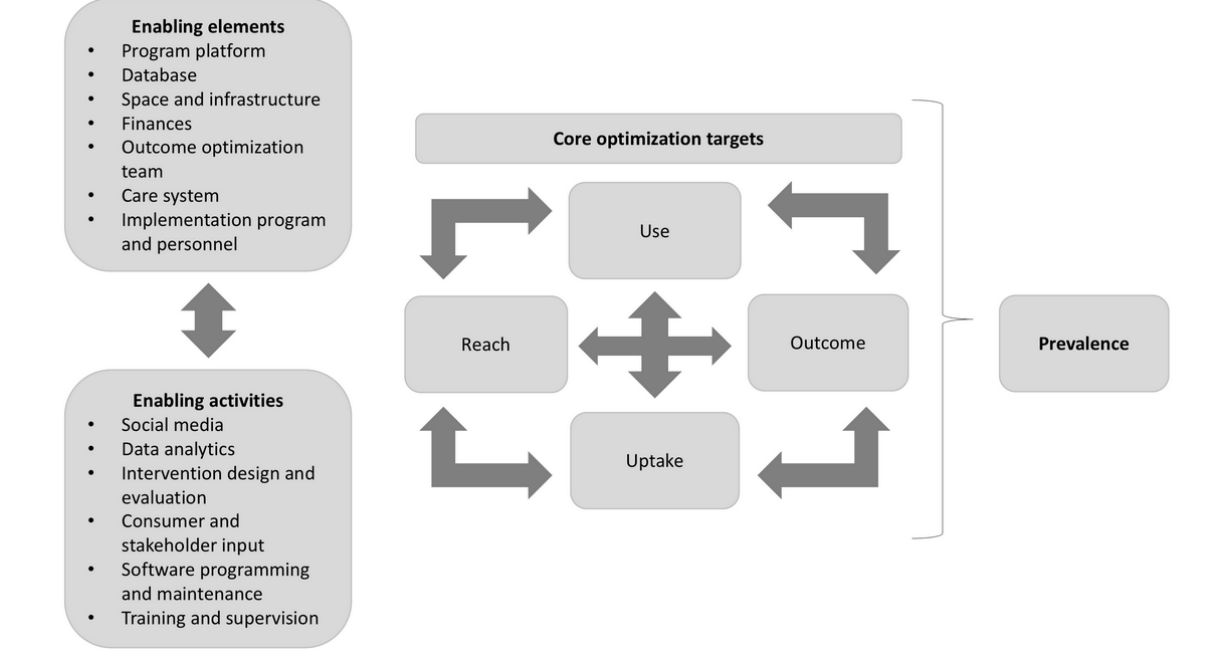
Figure 1. Outcome optimization model enabling elements, activities, and